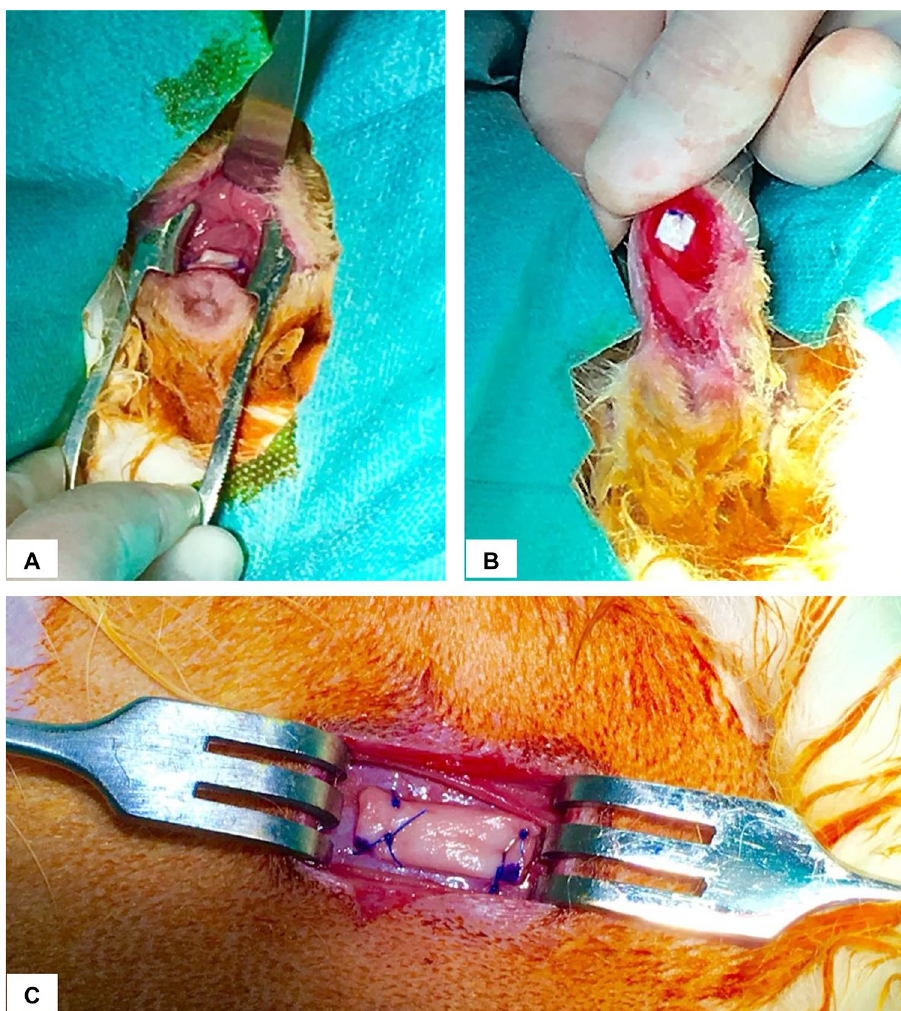
Figure 1. Vaginal and abdominal implant placement in NSW rabbit model. ( A ) hADM fixed in posterior vaginal submucosal layer. ( B ) hADM fixed in anterior vaginal submucosal layer. ( C ) hADM fixed in the subcutaneous tissue of the abdominal